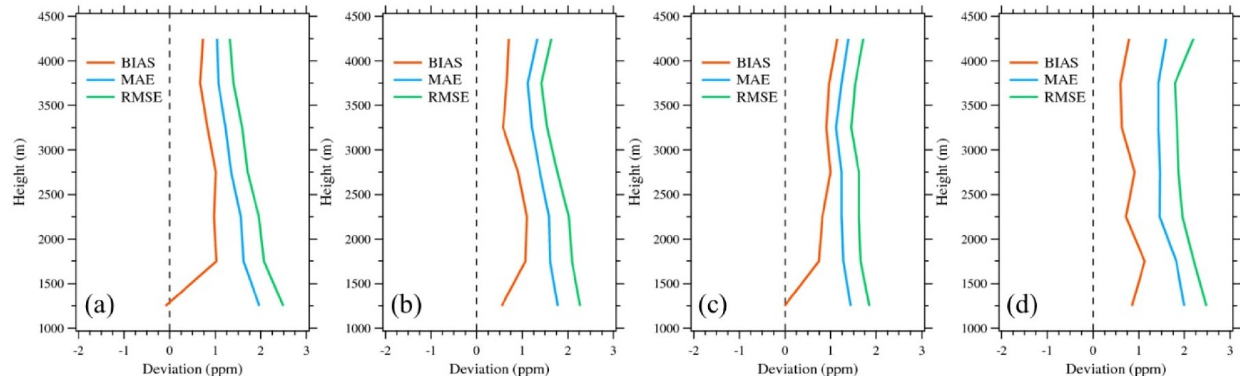
Figure 12. Statistical results at different heights against the observations in the Amazon basin ( a ALF; b RBA; c SAN; d TAB_TEF).